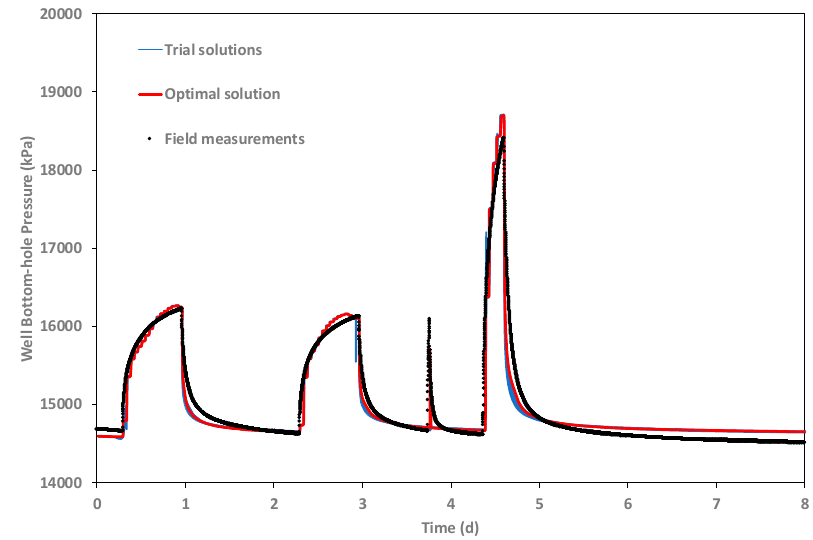
Figure 7. The evolution of the bottom hole pressure at the injection well HI during the single-phase history matching for different combinations (trial solutions) of the single-phase parameters.